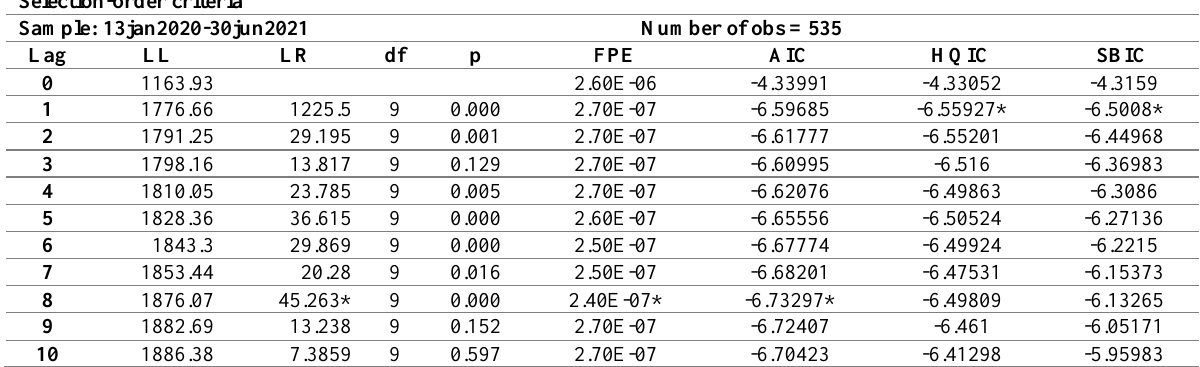
Table 4: Lag order selection